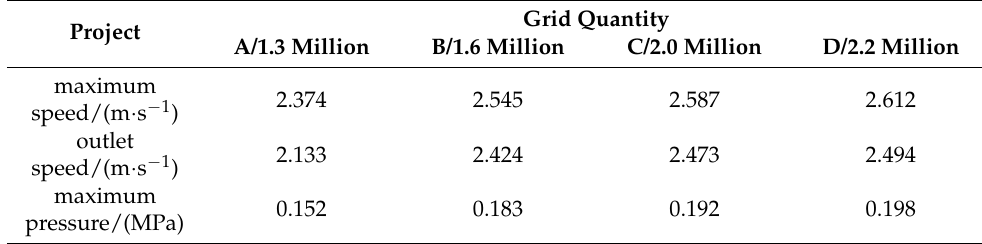
Table 1. Grid independence test.